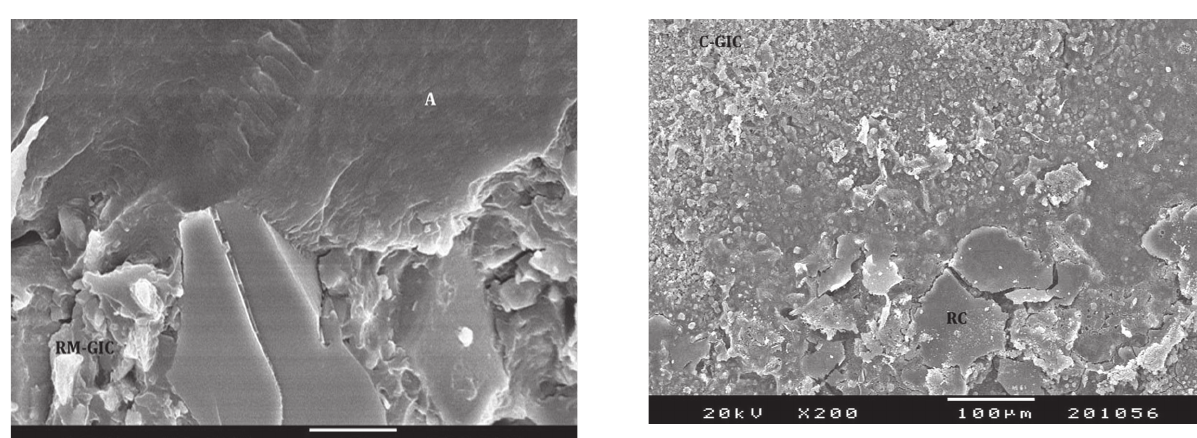
Figure 6- Prompt L-Pop adhesive coating and small deposits of composite resin (RC) on the conventional glass-ionomer cement (C-GIC) surface